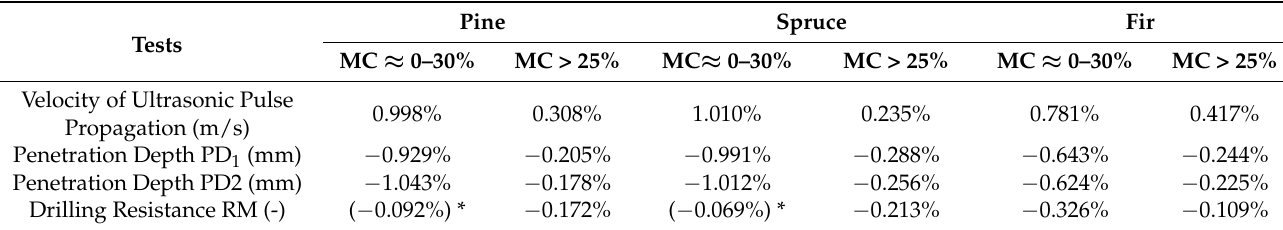
Table 3. Summary of percentage changes of NDT and SDT test results for 1% increase in moisture